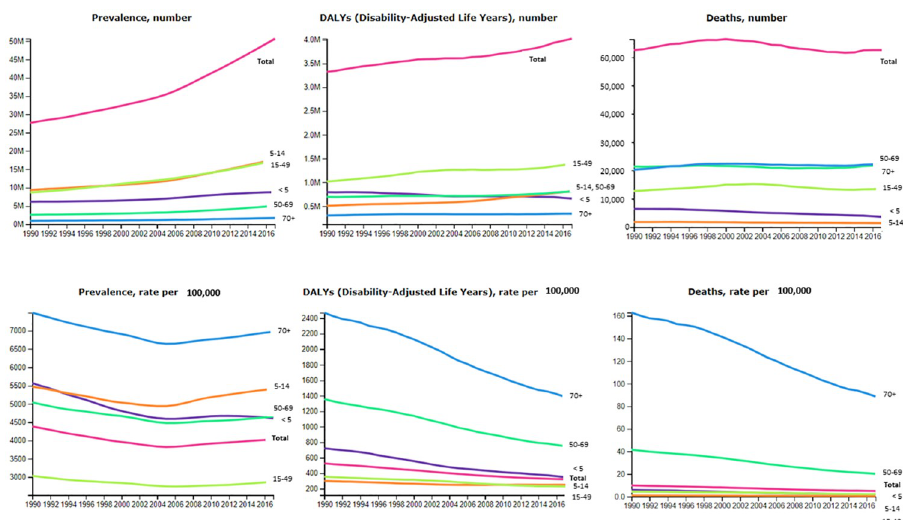
Fig 1. Trends in morbidity and mortality due to asthma in Africa. There has been a gradual increase in the prevalence, deaths and disability-adjusted life years attributed to asthma among adults in Africa over the years